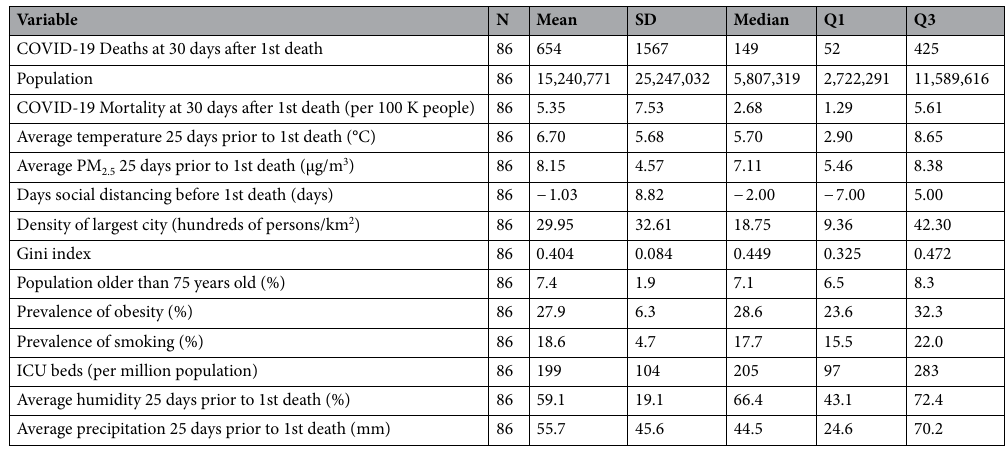
Table 2. Major study variables for all OECD countries and US states. 35 OECD countries, 50 US states and the District of